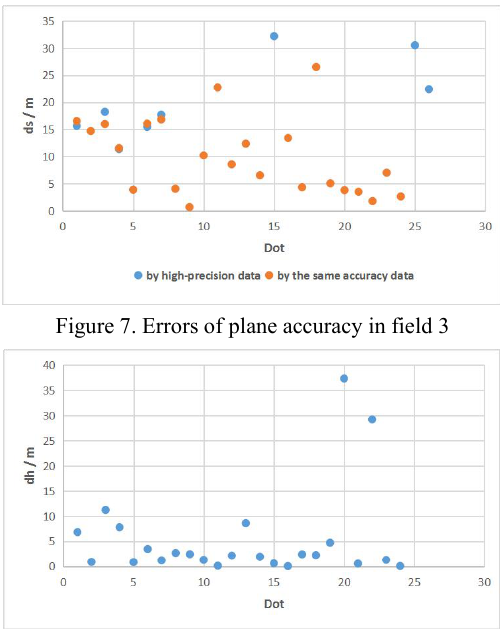
Figure 8. Errors of elevation accuracy in field 3